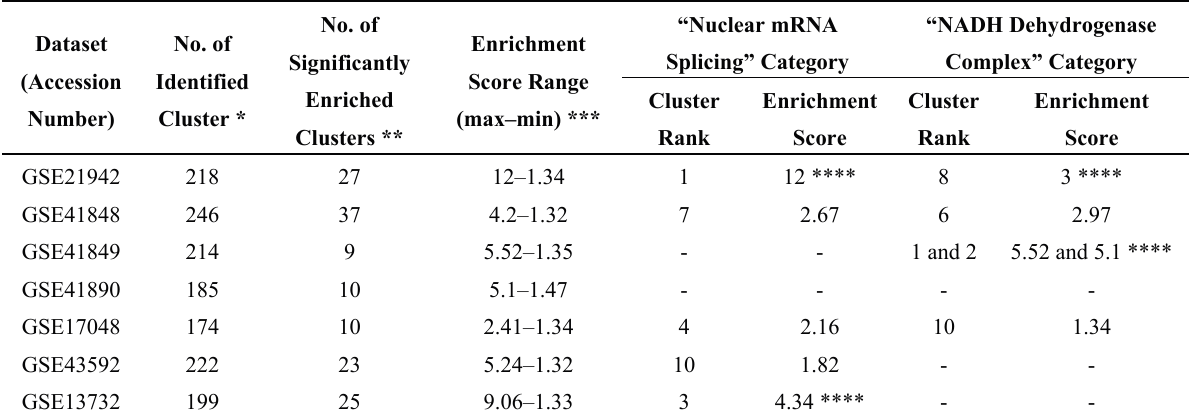
Table 2. Summary of the DAVID